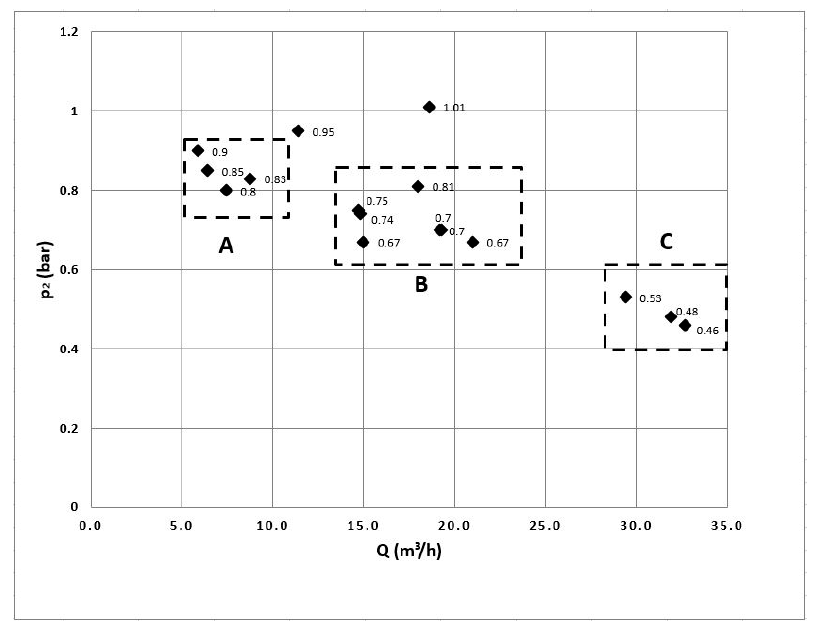
. Q ) show the degree of dispersion